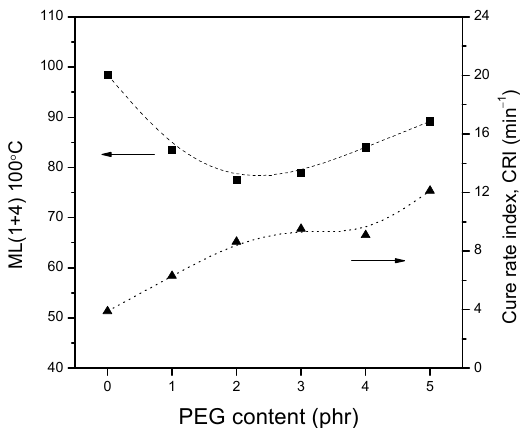
Figure 3. Vulcanization characteristics: ( a ) the time at 10% of curing degree (t10), optimum cure time (t90) and t90–t10 and ( b ) minimum torque (ML), maximum torque (MH) and MH–ML.